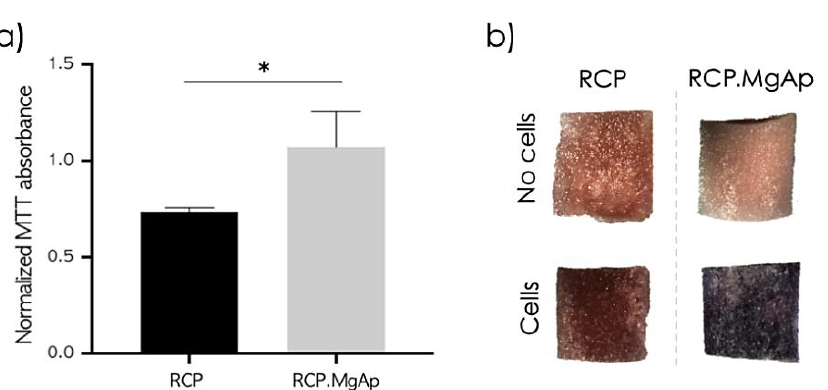
Figure 5. Cell viability of hMSC after 15 days of dynamic osteogenic culture. ( a ) MTT absorbance from full scaffolds was measured and normalized with dimethyl sulfoxide blank values. Statistical analysis using student t -test, * p < 0.05, n (RCP) = 3, n (RCP.MgAp) = 5. ( b ) Representative cross-sections images from MTT staining of non-seeded scaffolds (on top) and hMSC seeded scaffolds (on bottom) after 15 days of dynamic culture with osteogenic differentiation factors.